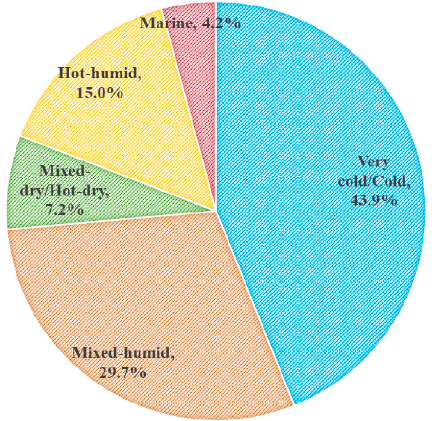
Figure 3. Site energy use in households in the US for different climate zones in 2015.